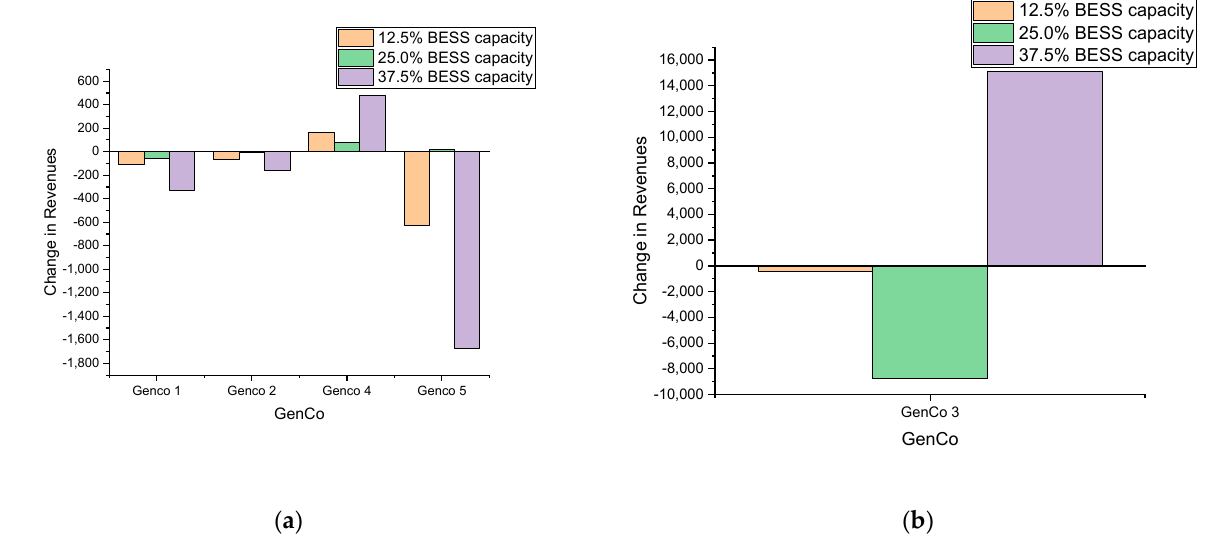
Figure 5. Change in Revenues of all GenCos as compared to Base Case. ( a ) Change in revenue of GenCos 1, 2, 4 & 5; ( b ) Change in revenue of GenCo 3.